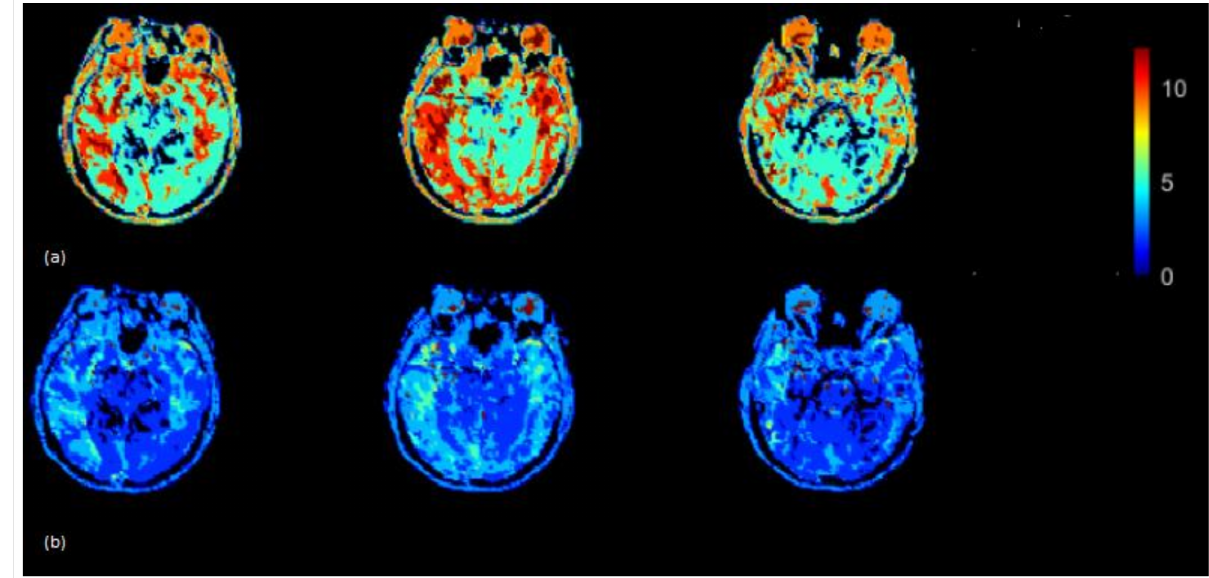
Figure 6. Tmax (seconds) map generated by using rescaled AIF ( a ) and non-rescaled AIF ( b ) for one subject. Tmax map generated using rescaled AIF represents increased values in the shown axial brain